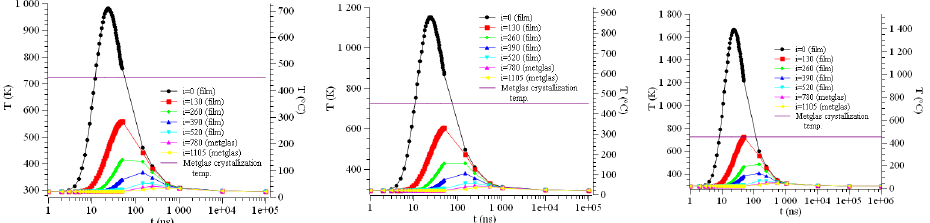
Figure 10. Temperature pro- file T ( t ) for F 0 = 80 mJ / cm 2 .